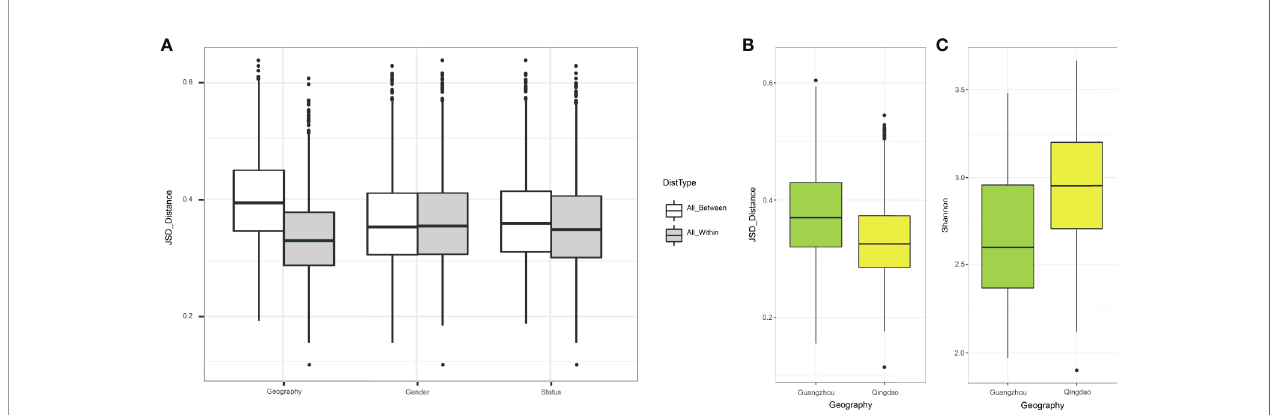
FIGURE 3 | The remarkable impact of city of origin on oral microbiomes. (A) The effect size of geography, gender and host ’ s disease status on saliva microbiota based on Jensen-Shannon distance. The city of origin exhibited the strongest effect on bacterial composition of the saliva microbiome, followed by host status and gender factor. (B) Beta-diversity difference between Qingdao and Guangzhou groups measured by JSD distances. (C) Alpha diversity difference between Qingdao and Guangzhou groups measured by Shannon